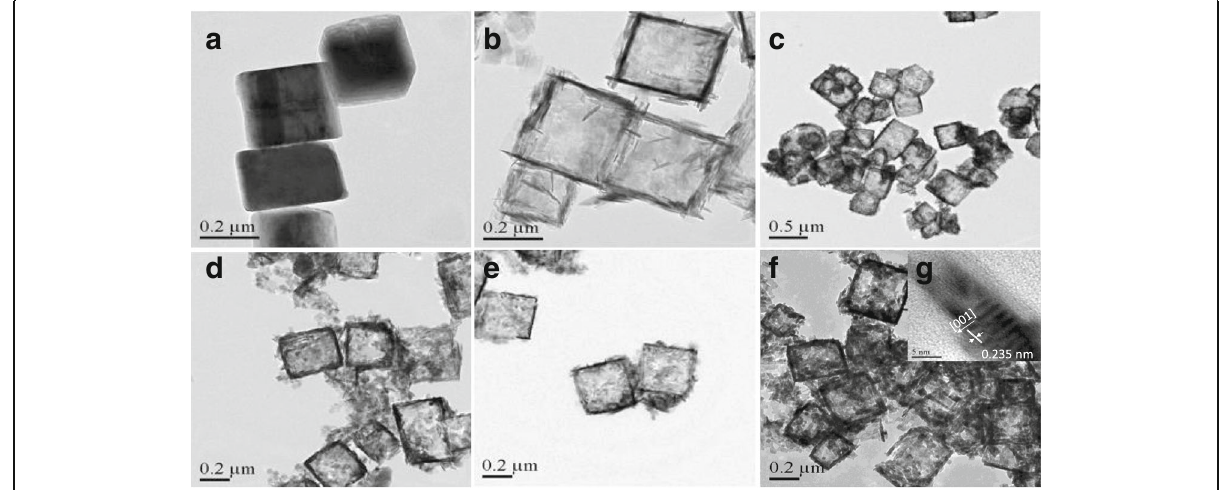
Fig. 1 TEM images of as-synthesized catalysts: a TiOF 2 , b TiO 2 -HNBs, c T-1p, d T-2p, e T-3p, and f , g